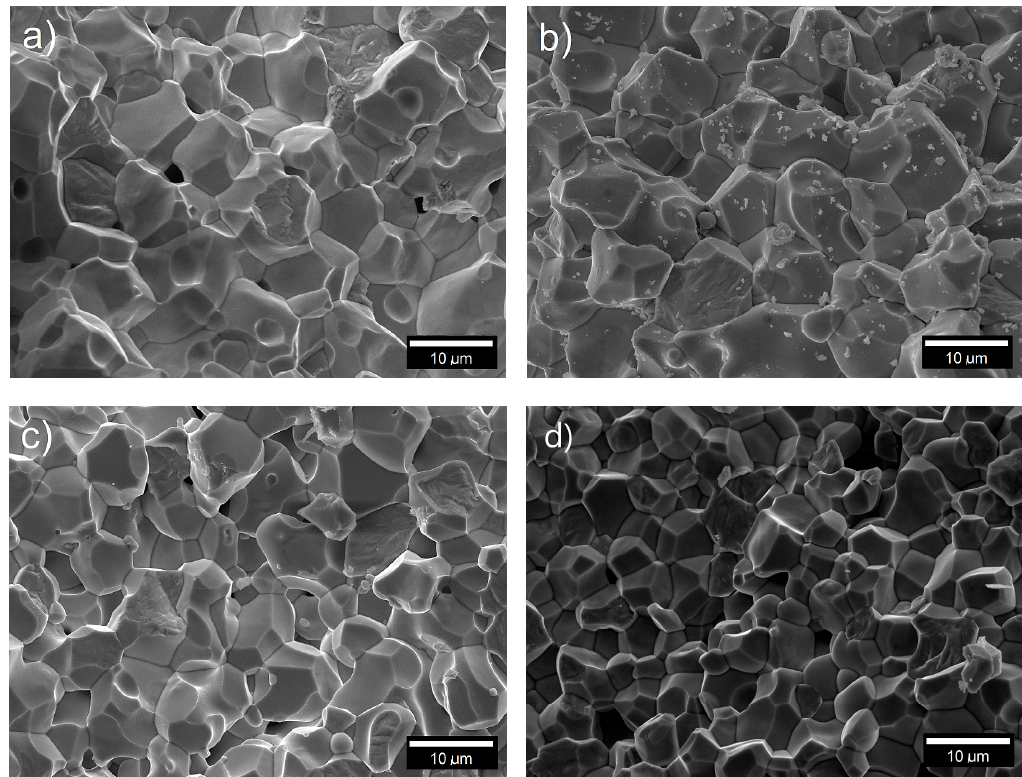
Figure 3. SEM images of the microstructure of the multicomponent PZT-type samples fractures. ( a ) samarium Sm 3+ (P-Sm); ( b ) gadolinium Gd 3+ (P-Gd); ( c ) dysprosium Dy 3+ (P-Dy); ( d ) lanthanum La 3+ (P-La).